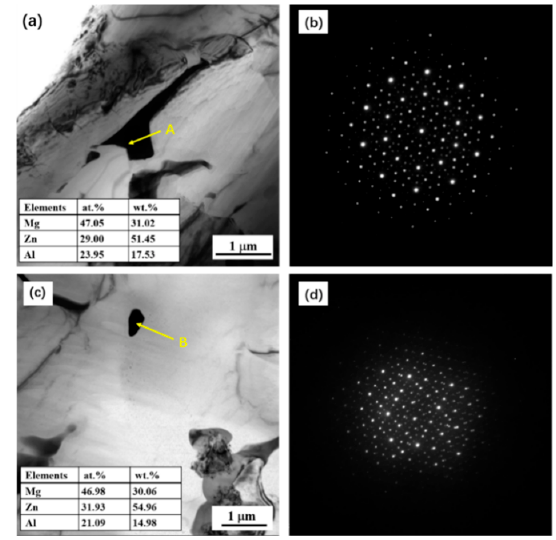
Figure 6. Bright-field transmission electron microscopy (TEM) images of I-phases ( a ) and ( c ) in the Mg-6Zn-4Al alloy; ( b ) and ( d ) are the corresponding selected area diffraction (SAED) patterns. The insets are the corresponding energy-dispersive X-ray spectroscopy (EDS) results.